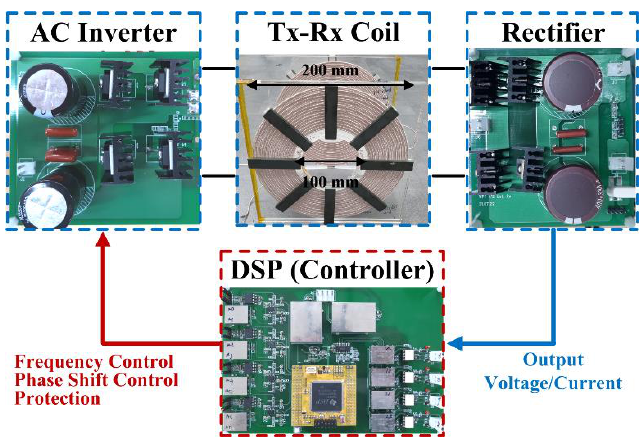
Figure 8. Prototype of the proposed single-stage wireless battery charging circuit. Table 1. Parameter values and components of the experimental circuit